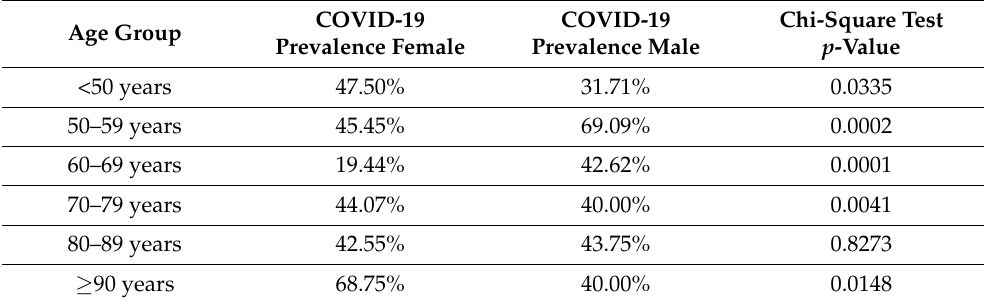
Table 2. Age statistics of the positive and negative groups. Except for p -values, all figures are in years.